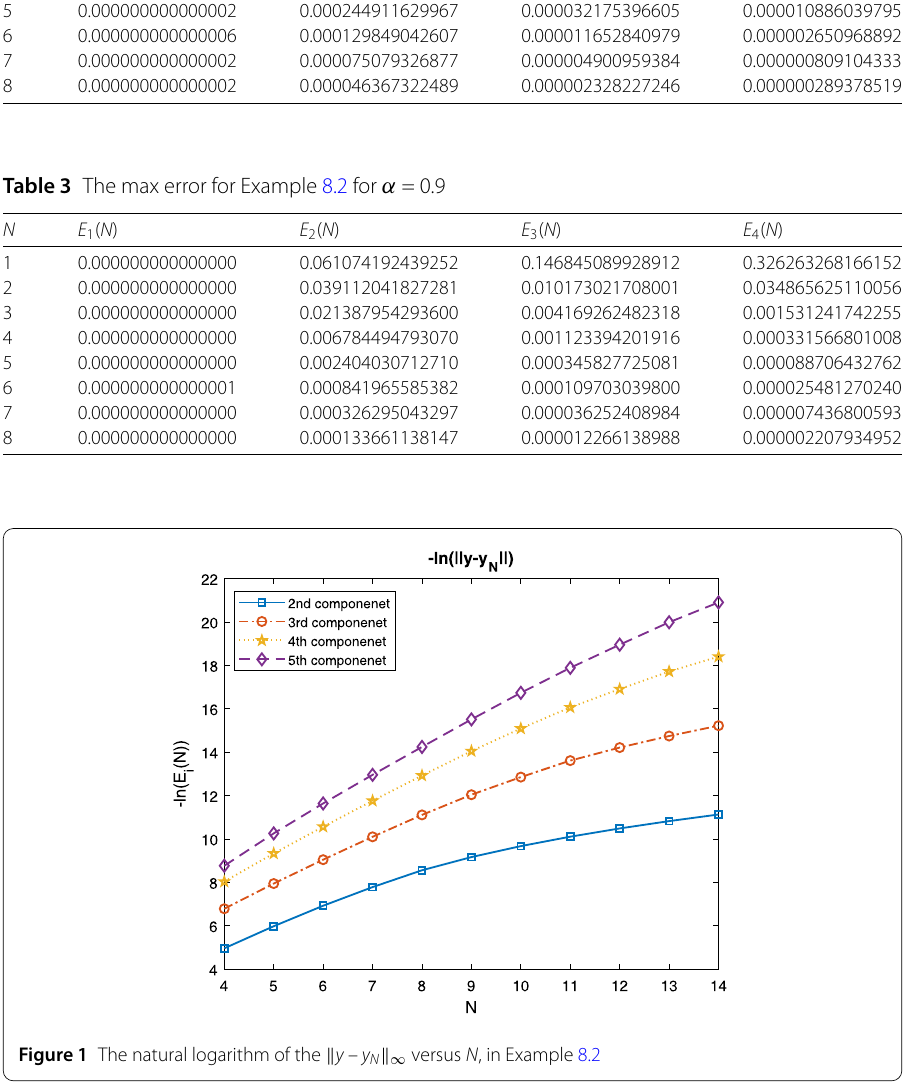
with exact solution y od ( t ) = [1, t , t 2 ,..., t n –1 ] T , on [0,1]. Tables 2 and 3 show the maximum error for α = 0.5 and α = 0.9 and various N . As these tables show, with increasing N the maximum error decreases rapidly and the proposed method converges to the exact solu-